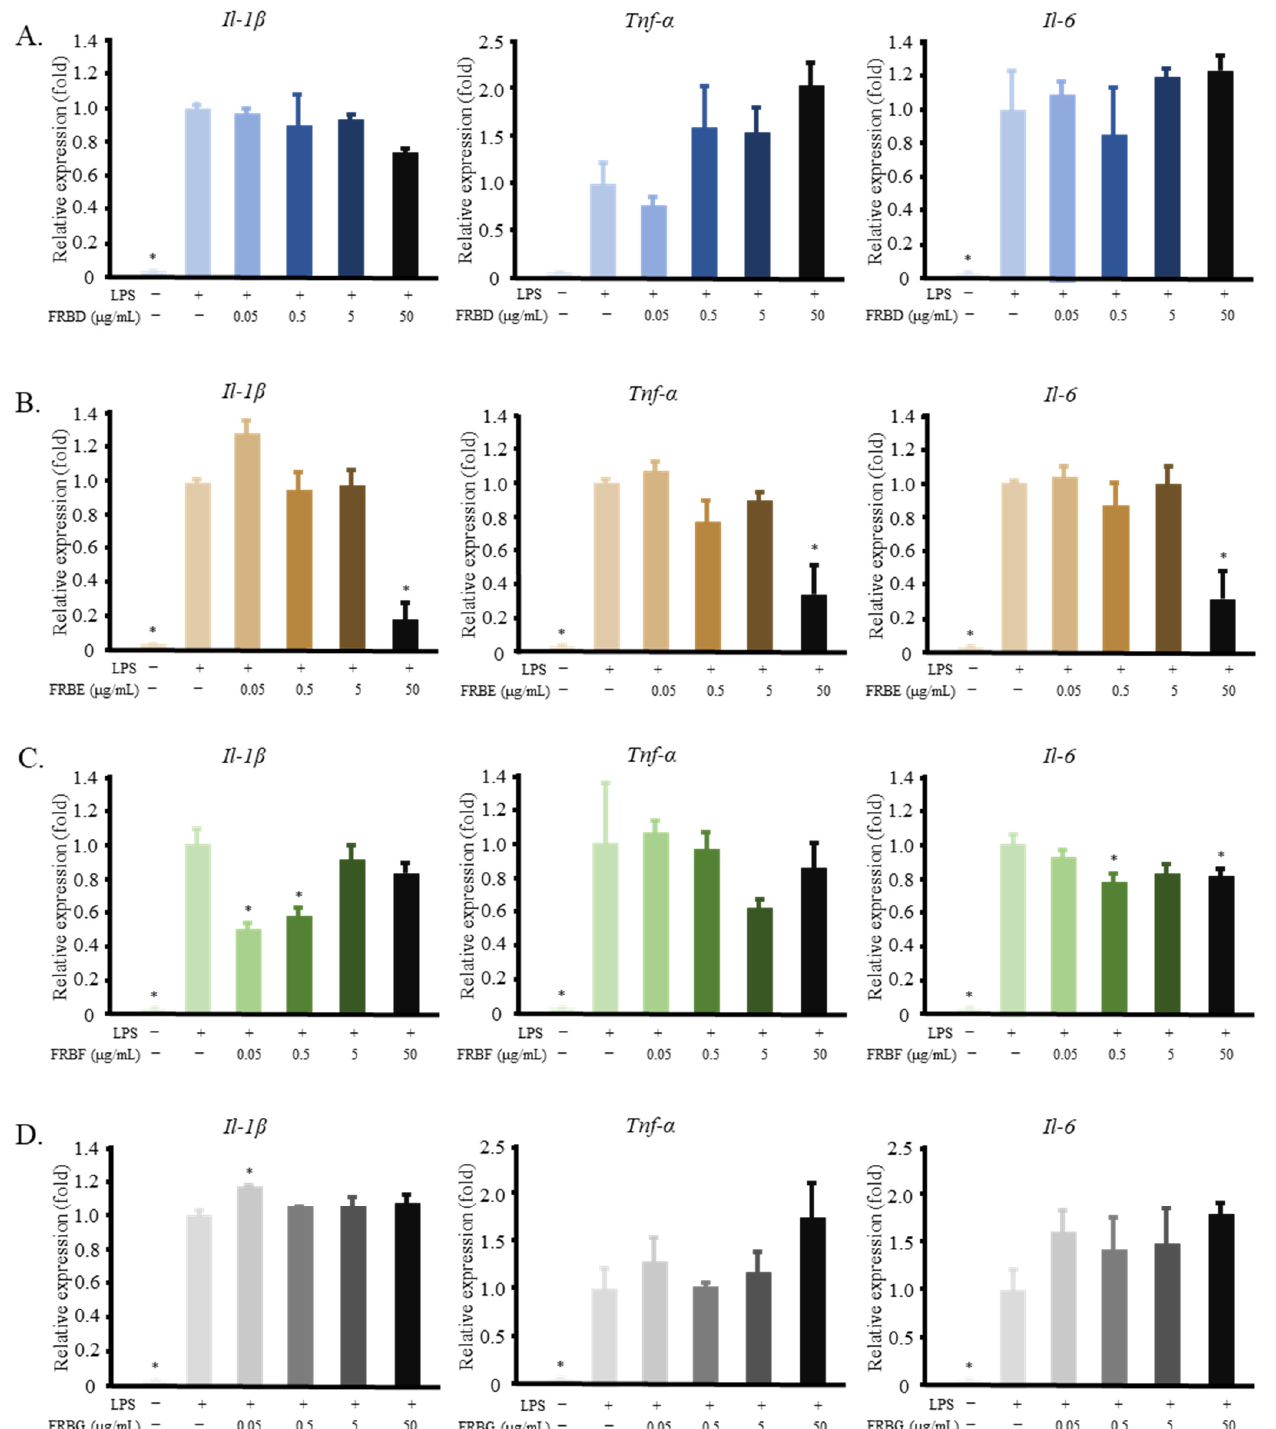
Figure 3. Fractionation of FRBA using a Sep-Pak Plus C18 cartridge resulted in fractions D–G, some of which possess the ability to reduce the inflammatory reaction of LPS-treated RAW 264.7 cells. ( A ) FRBD did not affect the expression of Il-1 β , Il-6 , or Tnf- α ; ( B ) FRBE decreased the mRNA levels of Il-1 β , Il-6 , and Tnf- α ; ( C ) FRBF reduced the expression of Il-1 β and Il-6 ; ( D ) The FRBR treatment did not affect the mRNA levels of the pro-inflammatory cytokines in the LPS-activated RAW 264.7 cells. The data are represented as mean ± SE, n = 3. Significant differences between the LPS group and the other groups (Dunnet’s analysis, p < 0.05) are marked with asterisks (*).